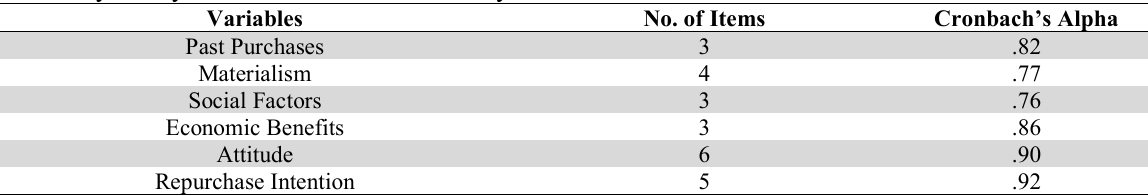
Reliability Analysis on Variables of the Study